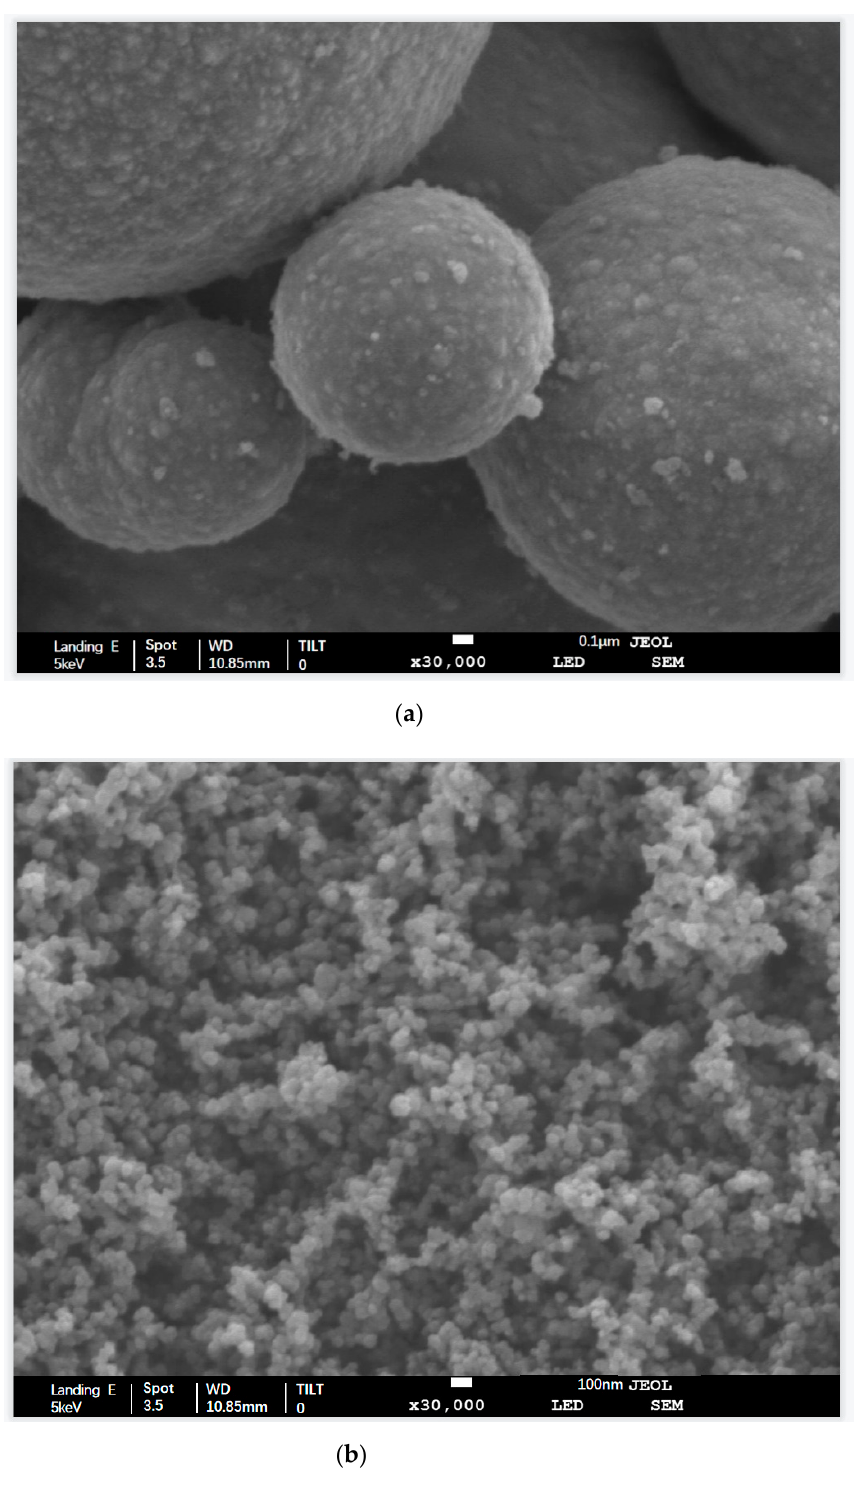
Figure 5. ( a ) Scanning electron microscope image of CIP; ( b ) scanning electron microscope image of CB.